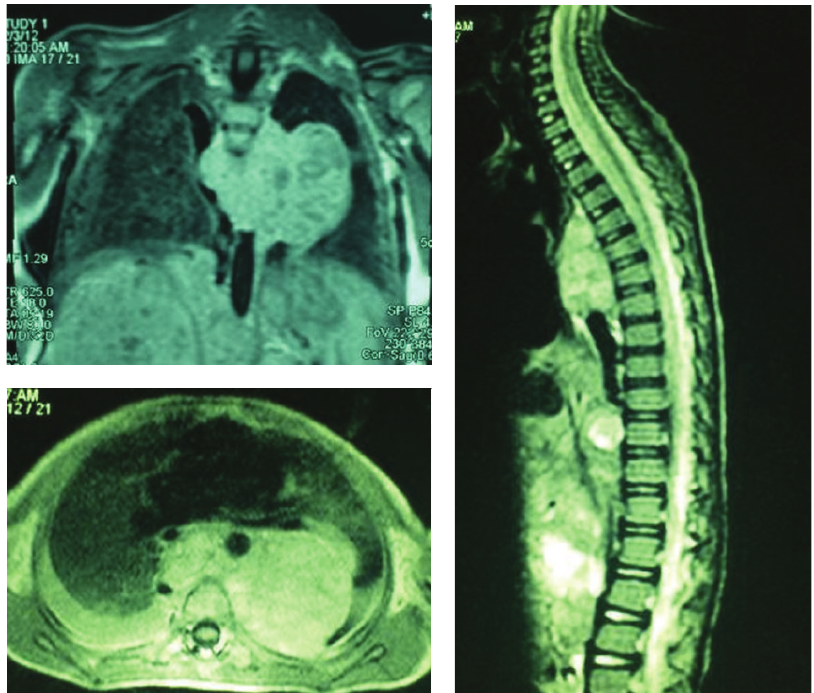
Figure 3: MRI showing left paravertebral mediastinal mass without intracanal invasion.